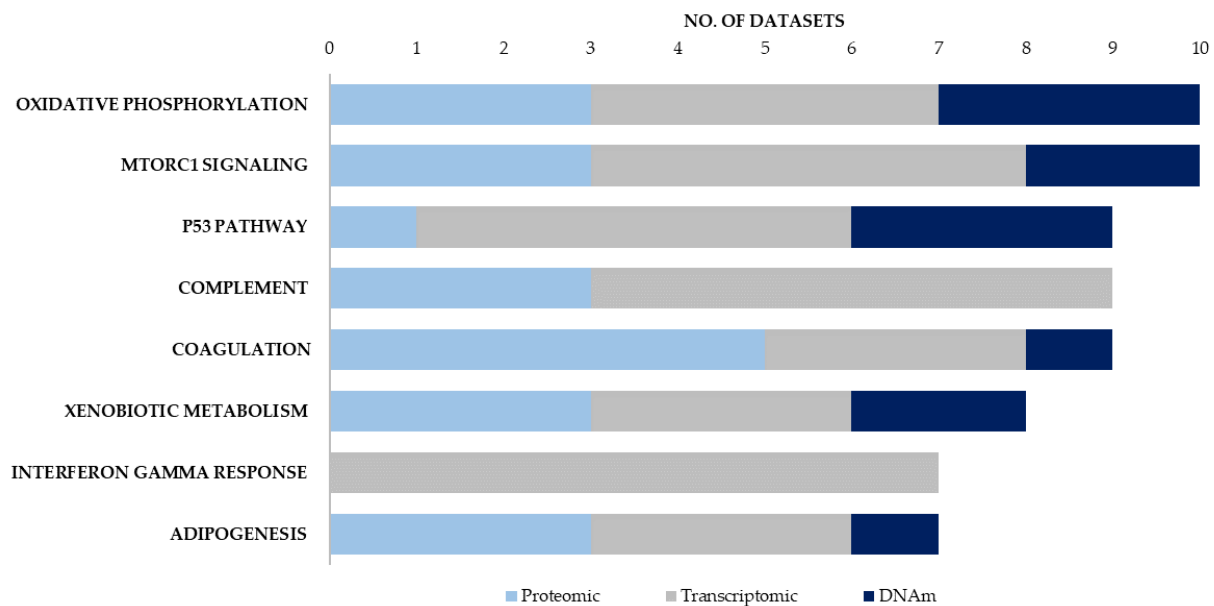
Figure 1. Hallmark canonical pathways most consistently implicated in ASD molecular data. Datasets were collated from 19 studies and meta-analyses on ASD papers published between 2017 and 2021: six proteomic, eight transcriptomic and six DNA methylation (DNAm) studies. All gene lists were converted into NCBI Entrez gene IDs. Each dataset was annotated with respect to the top 10 significantly enriched Hallmark canonical pathways. The Hallmark canonical pathways that were significantly enriched in seven or more independent ASD proteomic, transcriptomic and DNAm datasets are shown; those shown in bold are those consistently implicated using all three molecular approaches.